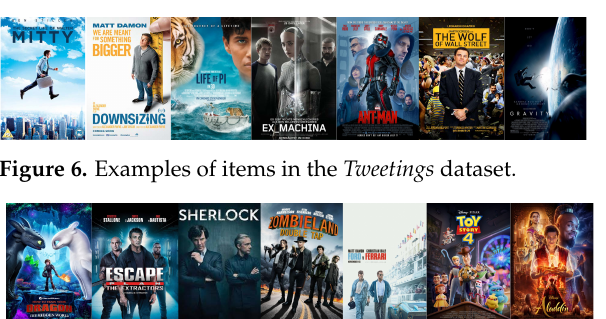
Figure 5. Examples of items in the Netflix dataset.